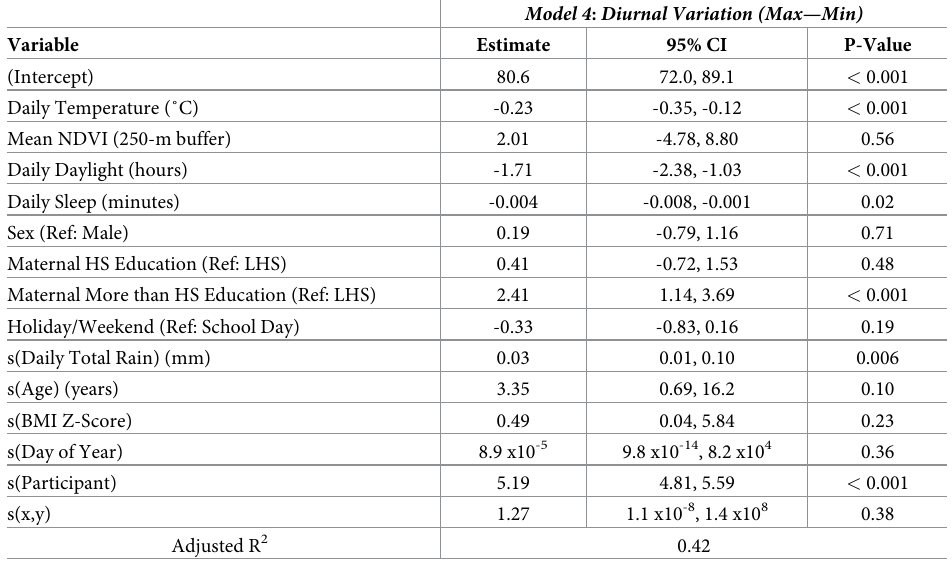
Table 3. GAM results continued with daily percent sedentary time as the outcome.